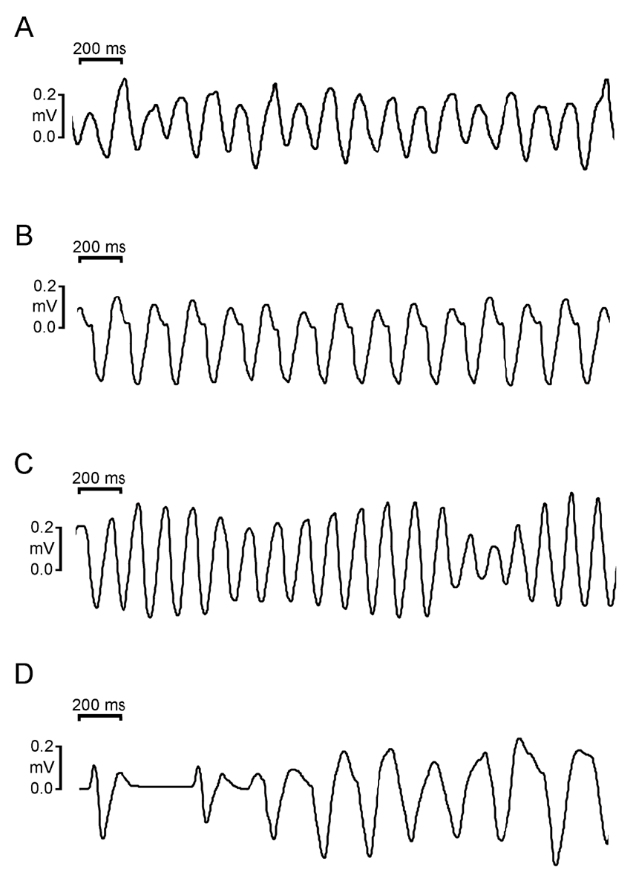
Figure 3. Development of various types of ventricular arrhythmias after the appearance of Brugada-pattern electrocardiographic (ECG) changes induced by lithium administration. The following representative ECG rhythm strips were recorded from lead II. ( A ) Ventricular fibrillation. ( B ) Ventricular tachycardia with right bundle branch block morphology. ( C ) Polymorphic ventricular tachycardia ( D ) Ventricular tachycardia occurred after a long-short sequence induced by the administration of 10.0 mmol/kg of lithium chloride in male rabbits. Table 2. Baseline ECG parameters in male rabbits with and without provokable Brugada-pattern ECG findings.